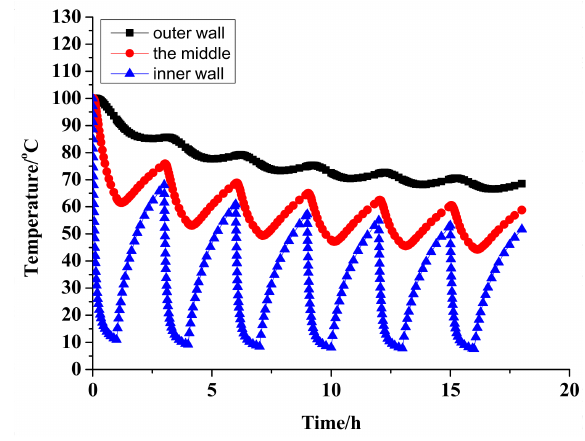
Figure 6. The temperature variation of cement